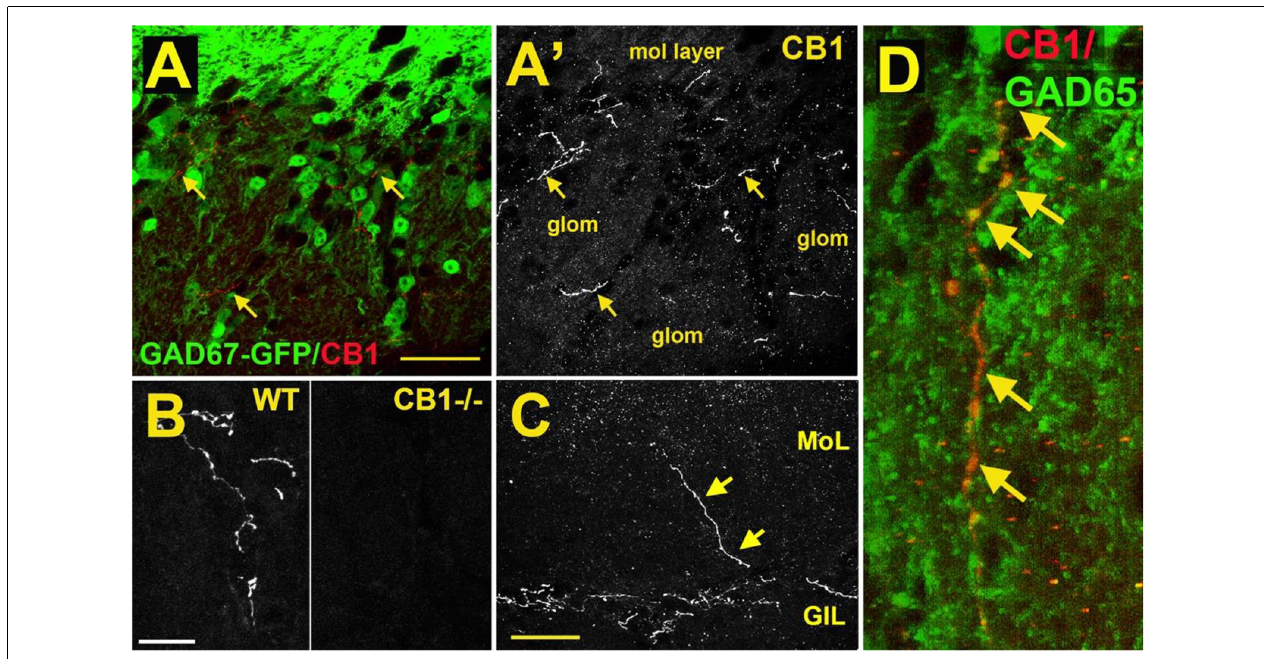
FIGURE 3 | CB 1 receptors are present in a sub-population of GAD65-positive periglomerular neurons of murine main olfactory bulb. (A) Micrograph shows GAD67-GFP (green) and CB 1 staining (red, arrows) in the glomerular layer of the main olfactory bulb. CB 1 and GAD67-GFP staining does not overlap. (A’) CB 1 staining from (A) shows that the staining for CB 1 is restricted to a few neuronal processes. EPL—external plexiform layer, glom—glomerulus. (B) CB 1 staining in sample WT and CB 1 − / − tissue taken at the same setting. (C) Micrograph shows rare process extending to the external plexiform layer. (D) Projection of a Z series of GAD65 (green) and CB 1 (red) staining shows a long overlapping process (overlap in yellow, arrows). Scale bars: (A) : 30 µ m; (B) : 20 µ m; (C) : 35 µ m; (D) : 10 µ m. Adapted from Wang et al.